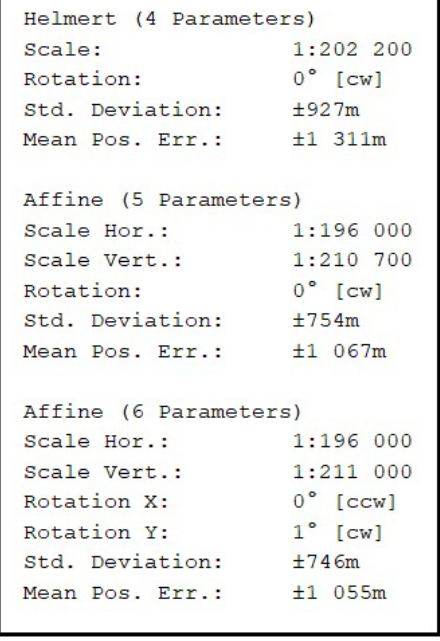
scale equal to 1:192,562. The error in the cal- culations may result from the inaccuracy of matching the stable points of the old map with